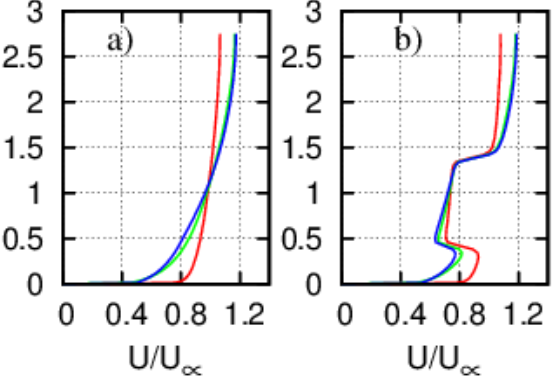
Figure 11. Dimensionless x-velocity along the domain depth for the inlet velocity v = 2.2 m/s at x = 160 m ( a ) and at the position of the first row of machines ( b ); red (5%), green (10%), blue (15%).